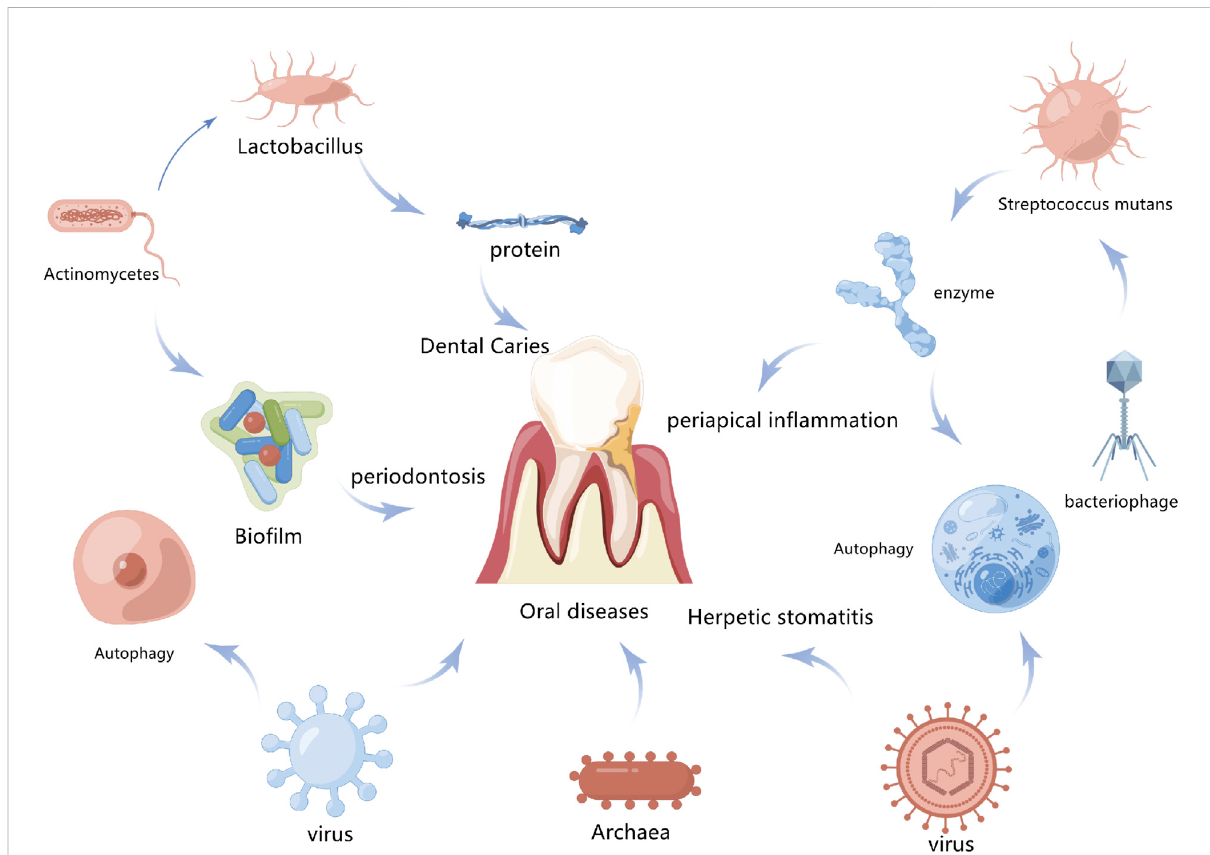
FIGURE 4 Association between autophagy and oral disease. Autophagy promotes the clearance of bacteria and toxins by infected cells and also contributes to the inhibition of in fl ammatory responses to maintain intracellular environment homeostasis, which is closely related to the occurrence and development of oral